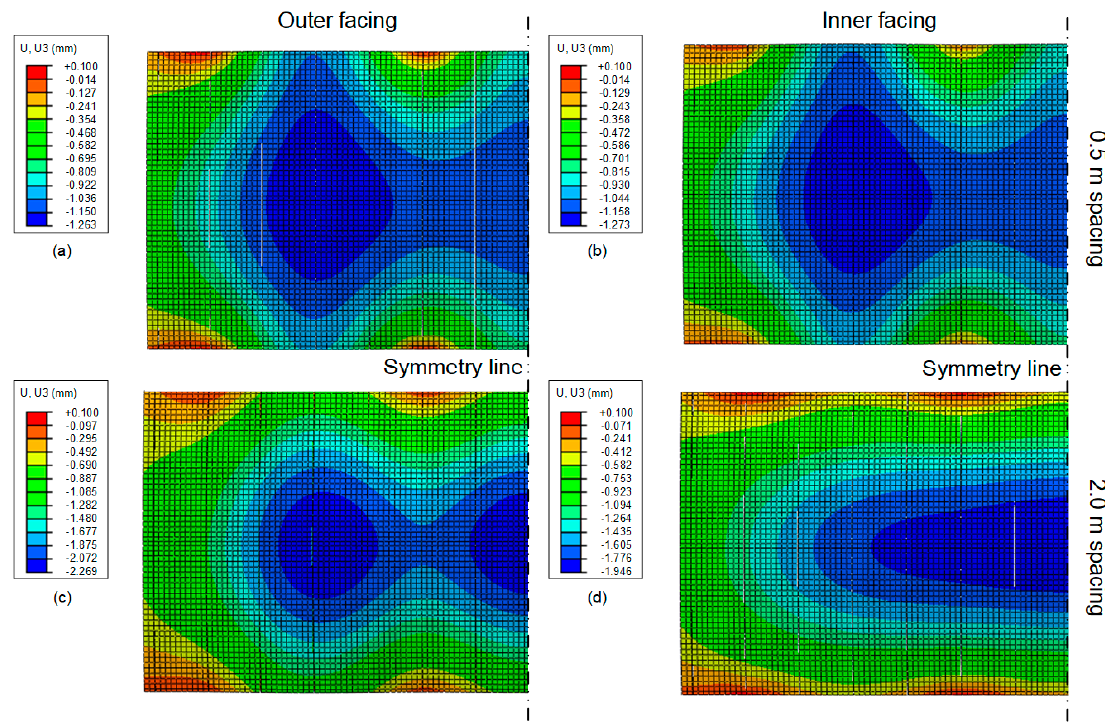
Figure 16. Out-of-plane deformation plots for LC2 at SLS for outer facing ( a ) and inner facing ( b ) for element with 0.5 m connector spacing, and outer facing ( c ) and inner facing ( d ) for element with 2.0 m connector spacing. Only half of the element is shown due to symmetry.